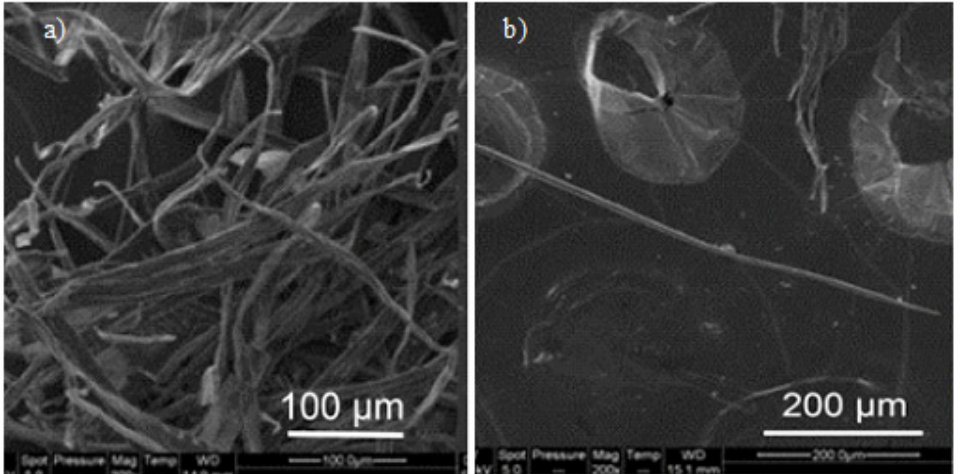
Figure 5. Scanning electron microscopy (SEM) images of different cellulose fibers; ( a ) bundles of unbleached fibers; ( b ) individual bleached fibers [81]. (Reprinted with permission from